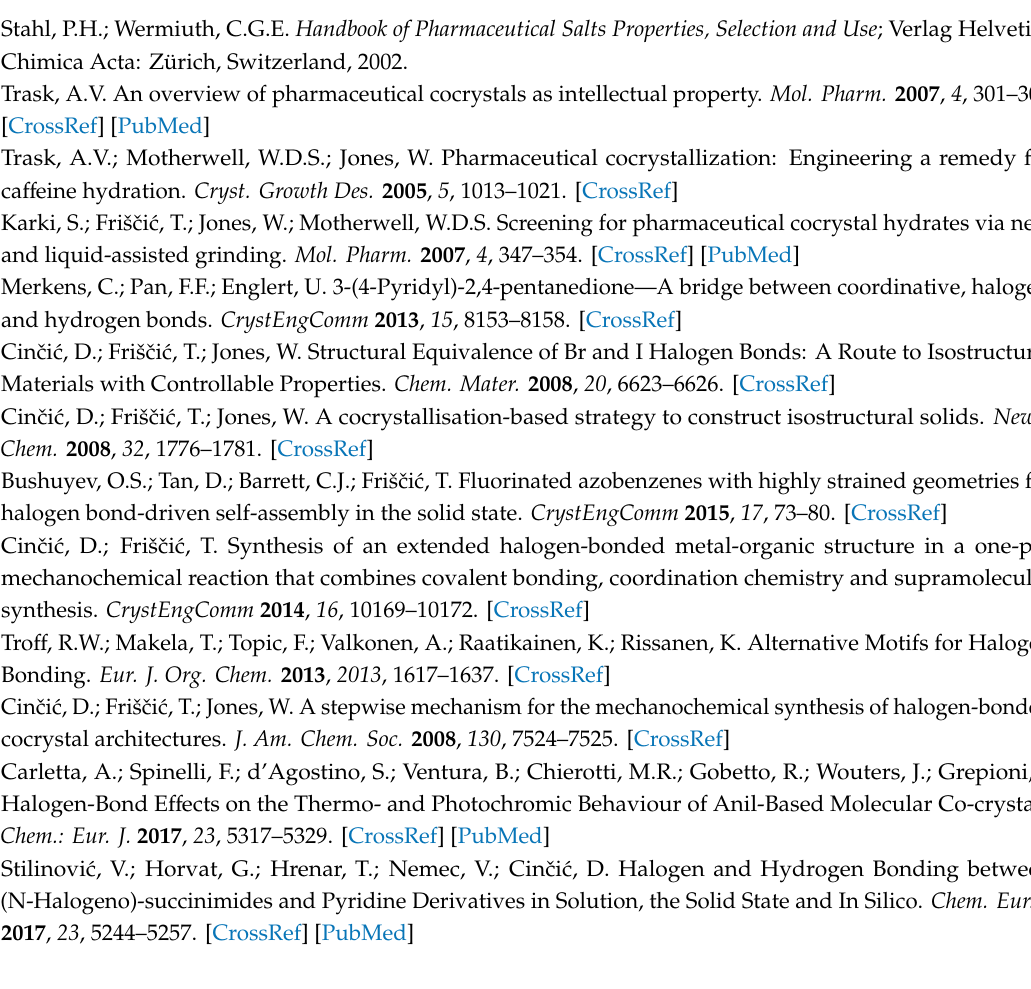
Figure S1: Structural motifs around the C–I ··· N XBs including 1,2,4-triazole moiety in CCDC structures; Figure S2: Structural motifs around the lp(I) ··· C interactions including 1,2,4-triazole moiety in CCDC structures; Figure S3: Powder X-ray di ff raction data (blue line) of mixture, obtained by mechanical grinding of 2 ASZ + 3( 1,4-FIB ) mixture with MeOH additions; Figure S4: Powder X-ray di ff raction data (blue line) of mixture, obtained by grinding of crystalline material grown from 2 ASZ + 3( 1,4-FIB ) solution in methanol; Table S1: Parameters of the C–I ··· N XBs including 1,2,4-triazole moiety in CCDC structures; Table S2: Parameters of the lp(I) ··· C interactions including 1,2,4-triazole moiety in CCDC structures; Table S3: Crystal data and structure refinement for ASZ · 1.5( 1,4-FIB ); Table S4: Cartesian atomic coordinates of model supramolecular